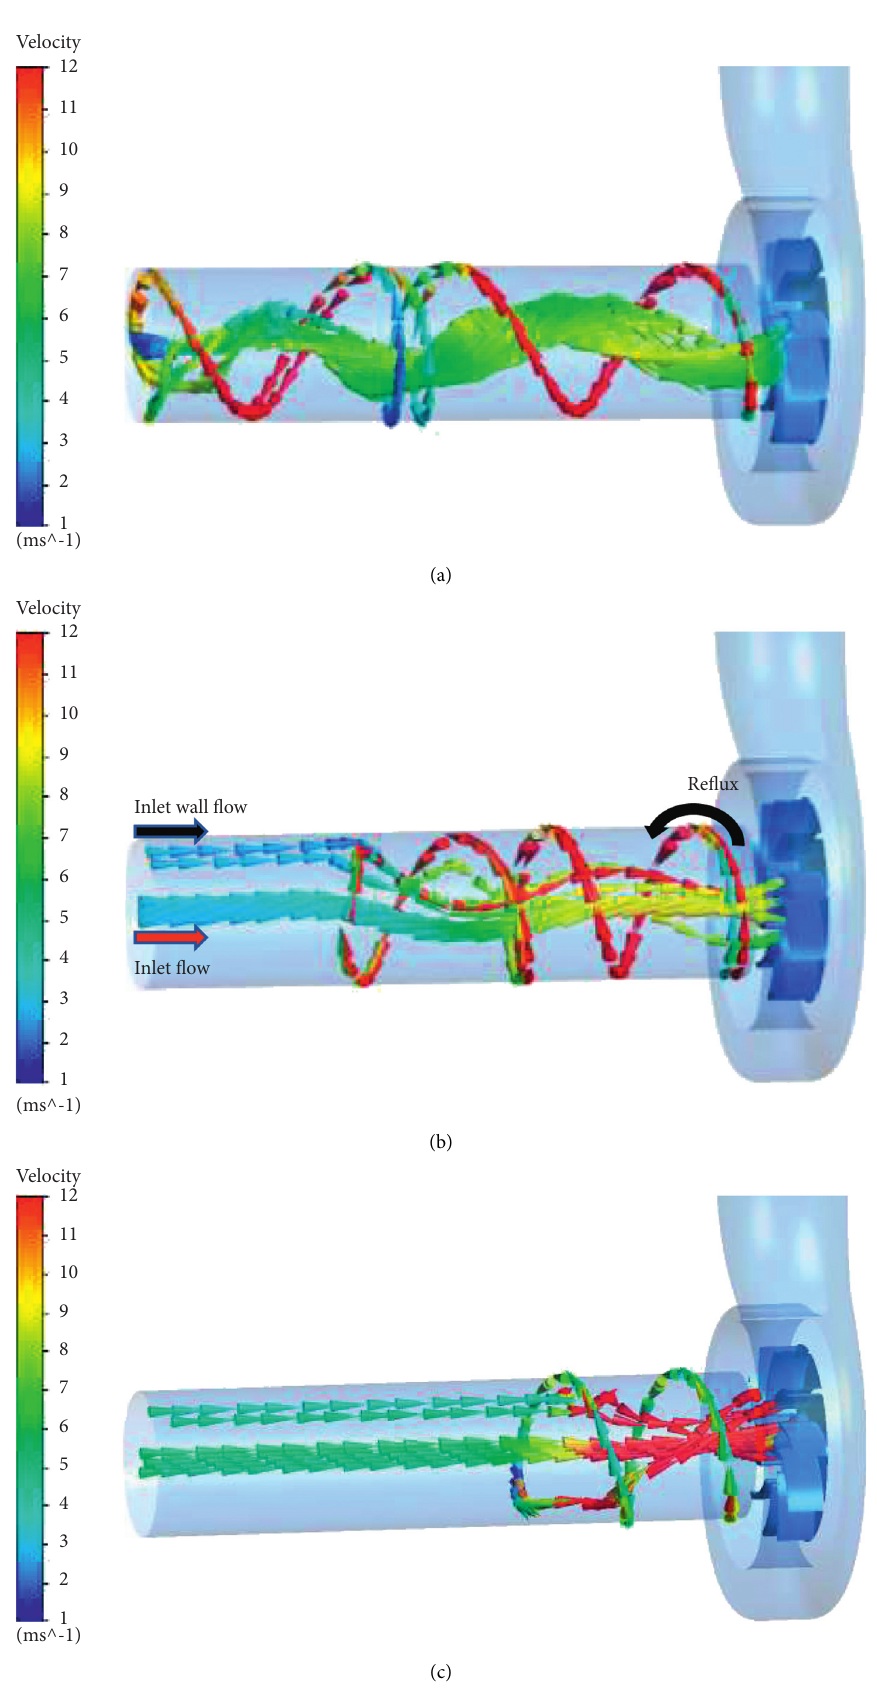
Figure 8: Swirl phenomenon in the inlet section of open-design vortex pump. (a) 0.6Qdes working condition, (b) 1.0Qdes working condition, and (c) 1.4Qdes working